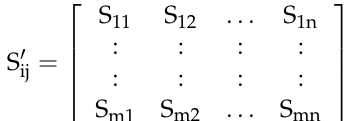
Table 7. Standardized Decision matrix S (cid:48)